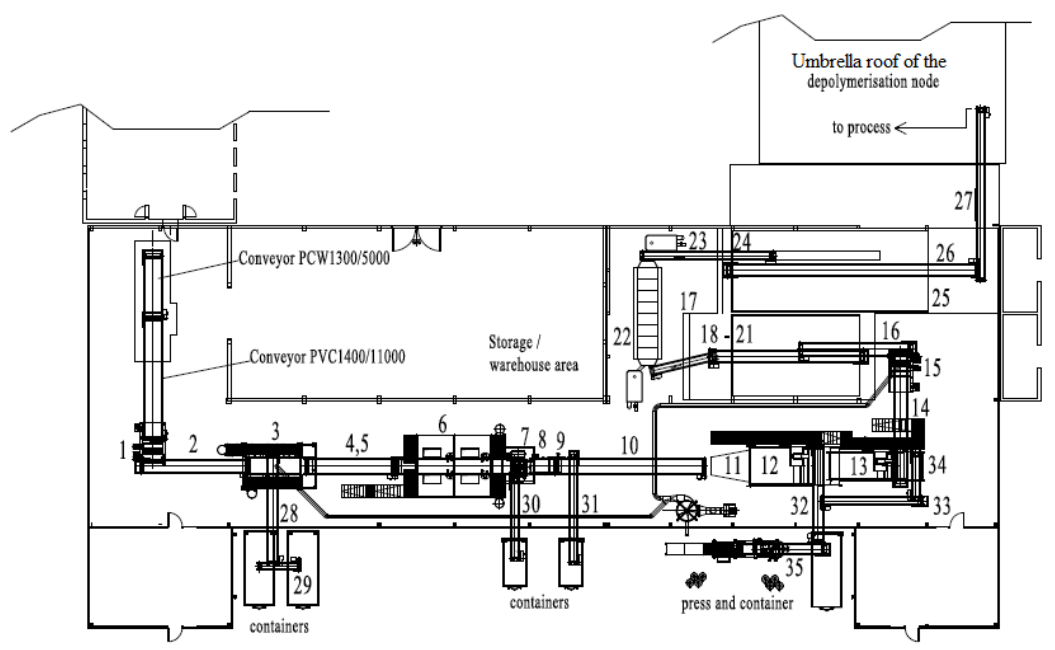
Figure 1. Floor plan of the sorting line; numbering of devices according to the tables above. Table 2. The devices according to the direction of the sorting